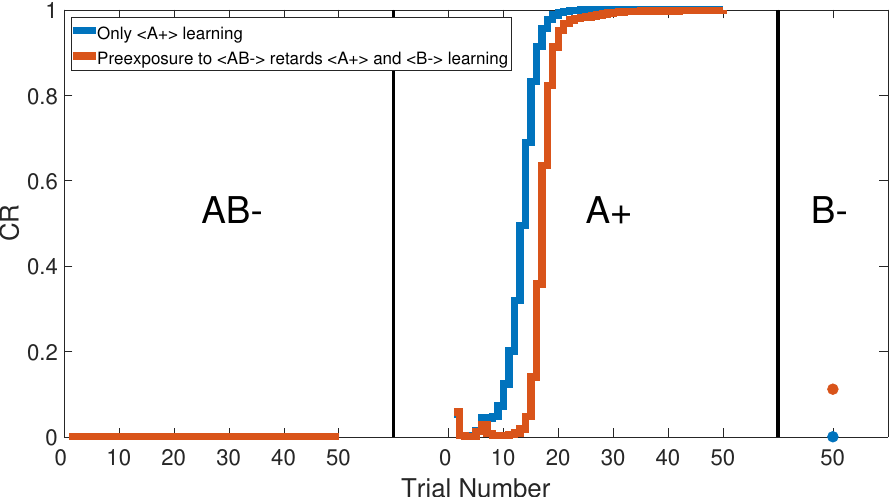
Figure 27. All three phases of sensory preconditioning task for the intact system of the